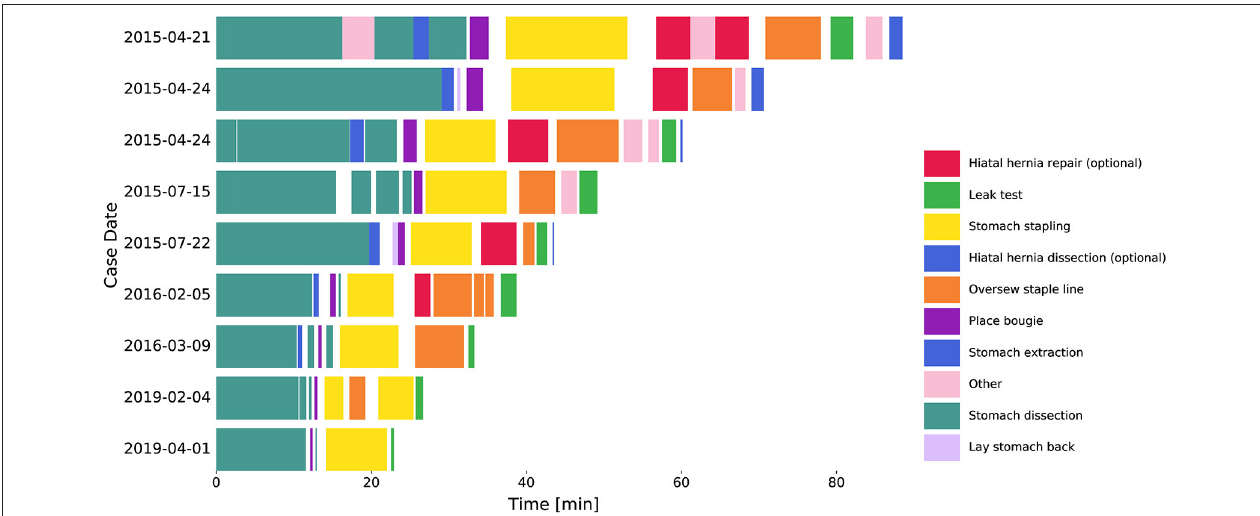
FIGURE 1 | Procedure workflow changes over years. Segmented tasks from 9 example cases. Hiatal hernia dissection and repair were excluded from further analysis. Surgical inactivity time was denoted as the gaps between